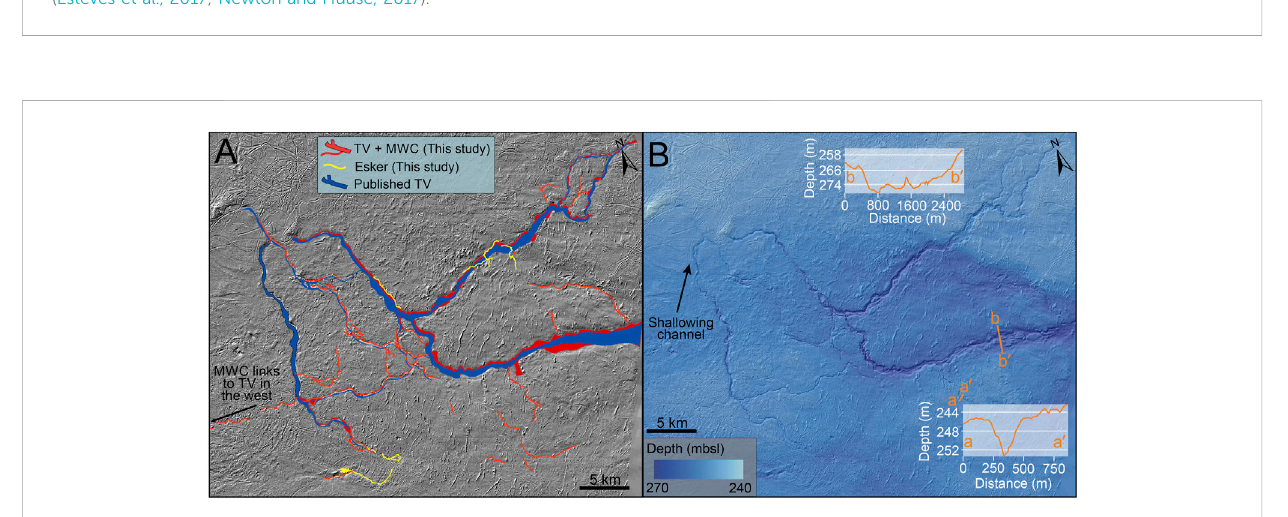
FIGURE 9 (A) Dendritic network of tunnel valleys and meltwater channels on northern Thor Iversen-banken, including those published in previous studies (Newton and Huuse, 2017) and additional landforms presented and mapped in this study. (B) Shaded relief map and pro fi les showing dimensions of the tunnel valley system and meltwater channels mapped in (A)